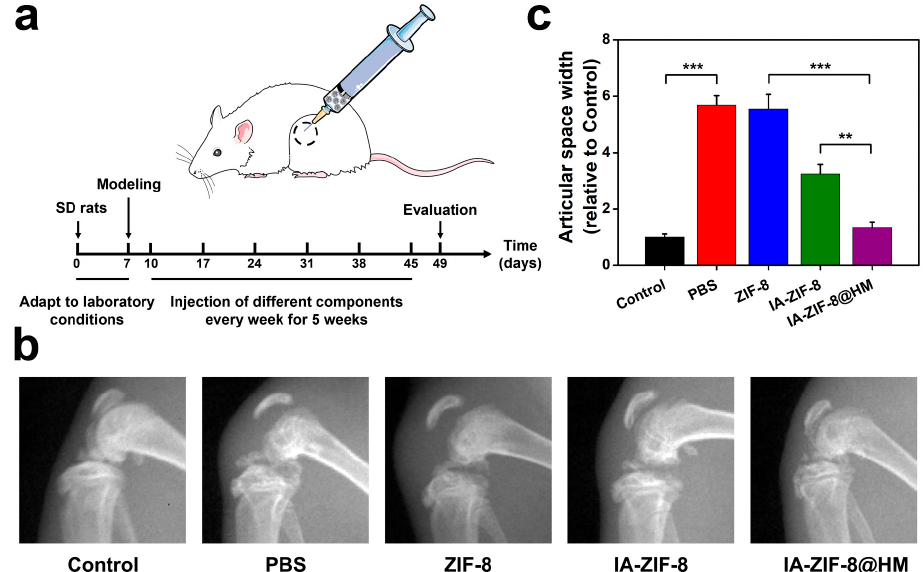
Figure 4. In vivo therapeutic effect of composites. ( a ) Overview of in vivo experiments. ( b ) The X-ray images of different groups after the treatment. ( c ) The relative articular space width of different groups (** p < 0.01, *** p < 0.001).